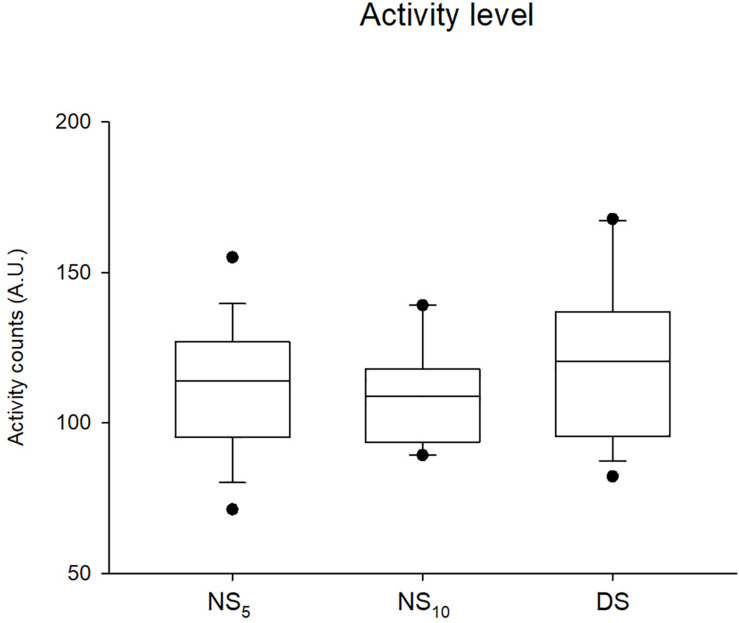
Actigraphic activity measured during the three shift cycles in the 5-day night shift (NS5), the 10-day night shift (NS10), and the day/swing shift (DS) group. Black dots represent the 95th/5th percentile.